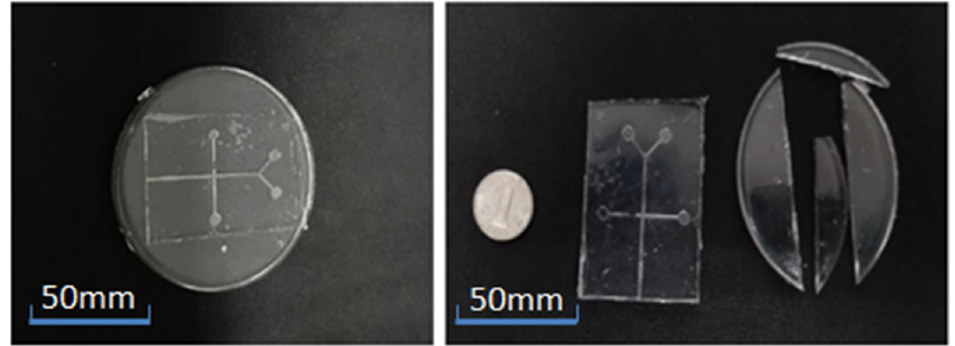
Figure 6. Chip before cutting and after cutting.